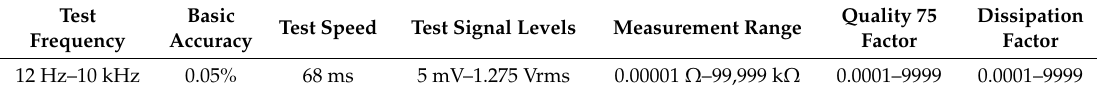
Figure 6. Carbon nanotube (CNT)- graphene composite sample with conductive silver (Ag) paste.